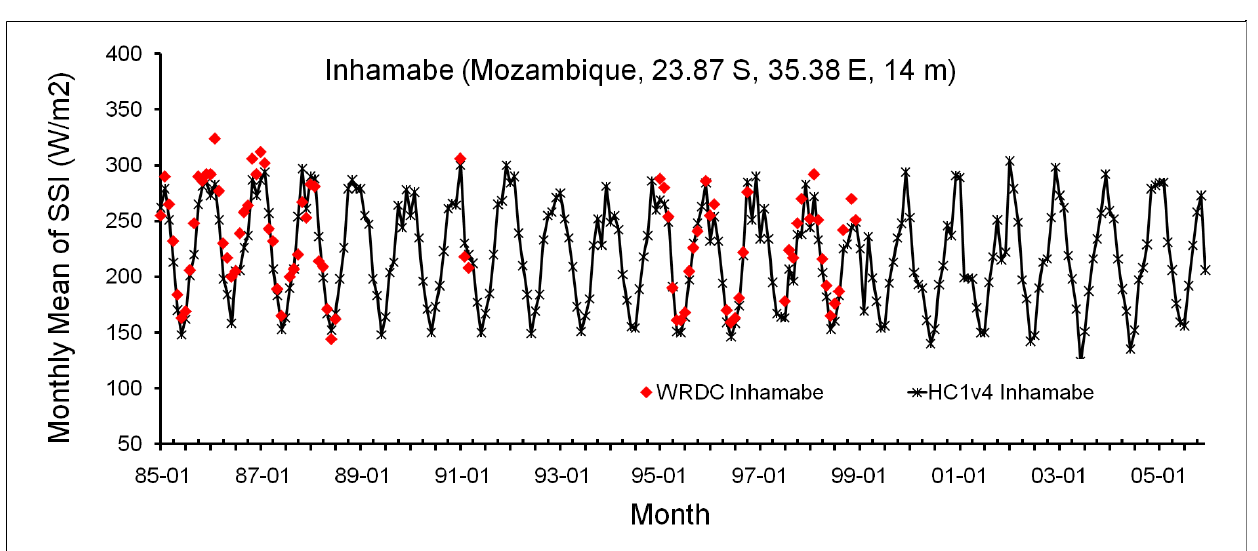
Figure 2. Monthly means of SSI from HC-1 in Inhamabe during the period 1985–2005 and comparison with the available ground-based measurements